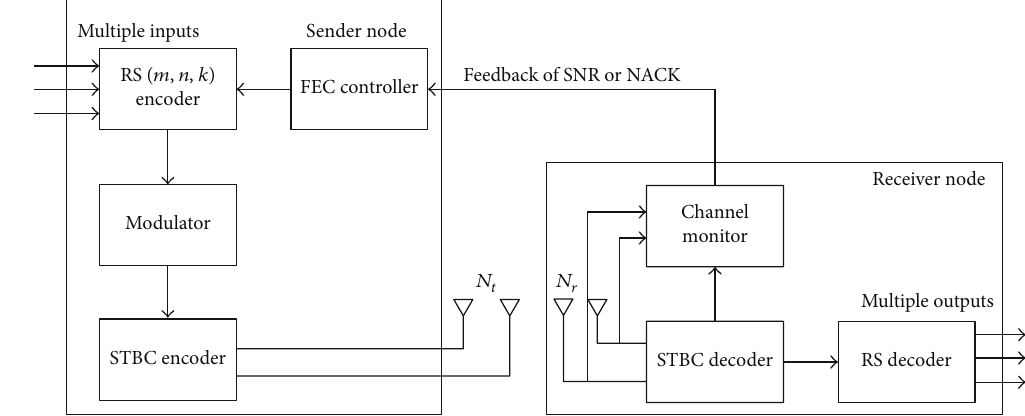
Figure 1: Network model of FEC-MIMO.